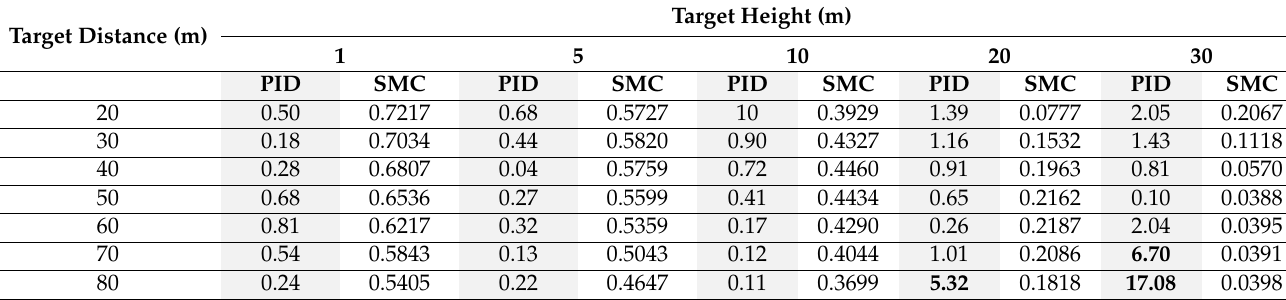
Table 7. Accuracy errors of shots fired at targets from a moving straight forward robot with PID and SMC.